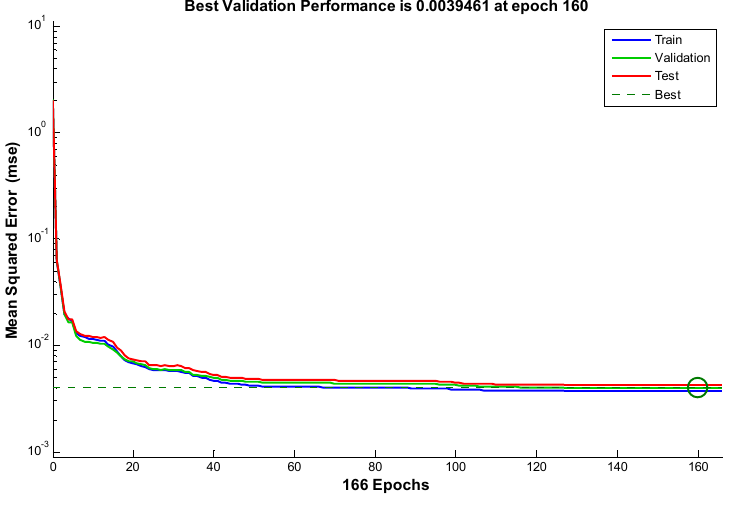
Figure 2. Validation Performance plot.